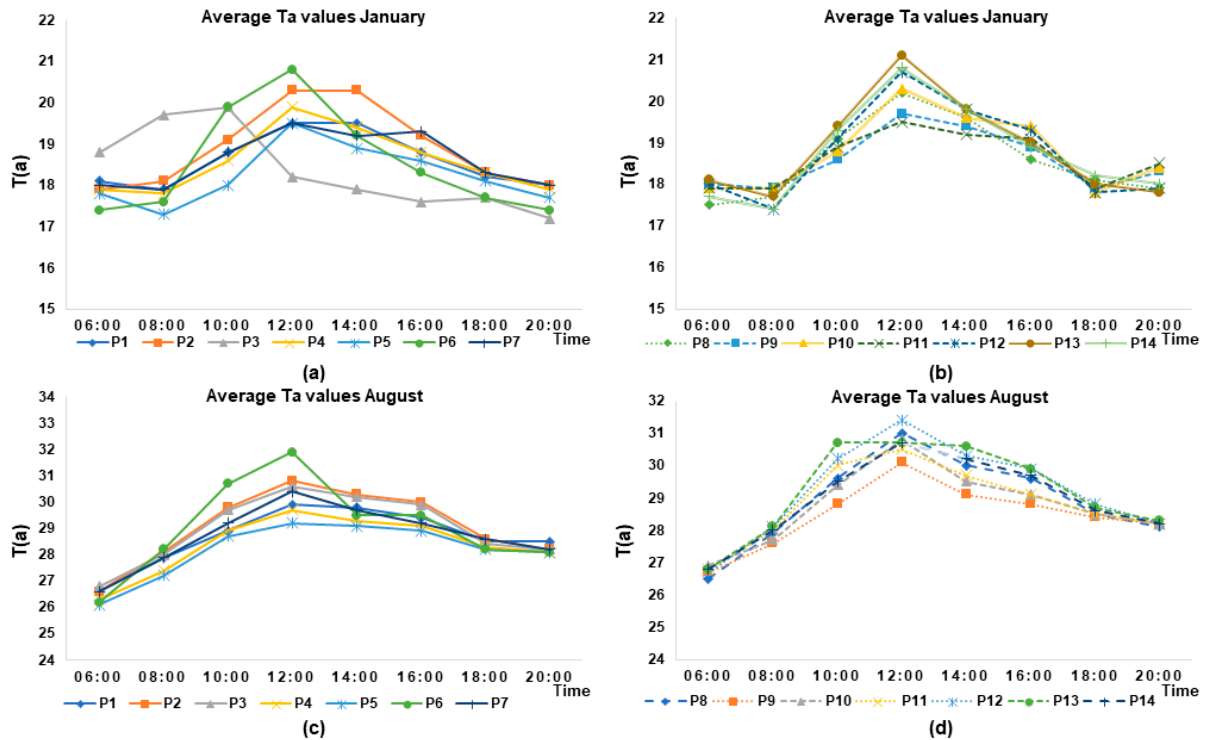
Figure A1. Distribution of the average daily air temperature at the 14 points studied in January ( a , b ) and August ( c , d ).